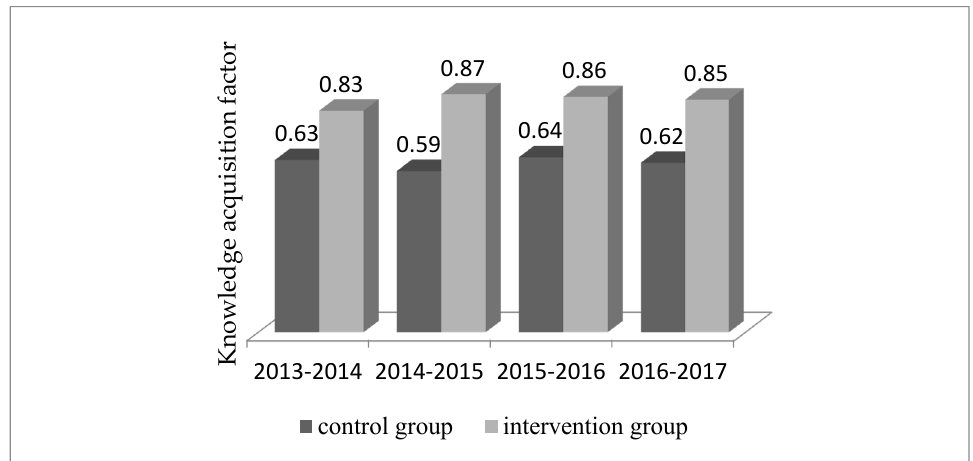
Figure 6. Diagram of dynamics of knowledge acquisition factor for control and intervention groups for the first year of studies.